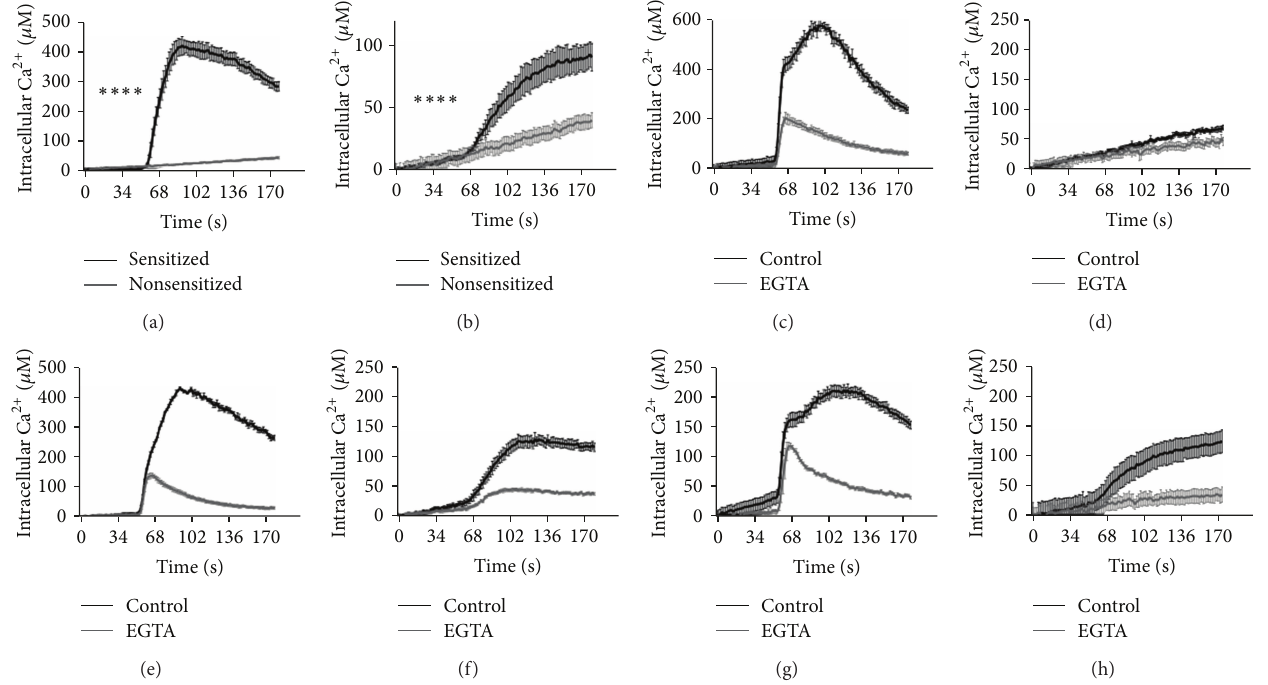
Figure 4: Calcium mobilisation in mast cell subsets. Fura-2/AM-loaded resting, nonsensitised (a) & (b) or anti-DNP IgE (0.5 𝜇 g/mL)- sensitised (a)–(h) mucosal-type BMMC (e) & (f), CTMC (g) & (h) and PDMC (a)–(d) were stimulated at 50s with DNP (0.5 𝜇 g/mL) to induce cross-linking (XL) of Fc 𝜀 R1 (a), (c), (e) & (g) or 0.5 𝜇 g/mL LPS (b), (d), (f) & (h), and intracellular calcium mobilisation and influx recorded in real time using excitation-emission ratios of 340/380 nm (a)–(h). For analysis of intracellular mobilisation alone, the cells were stimulatedincalciumfreeHBSSsupplementedwith100 𝜇 MEGTAtoremoveallextracellularcalcium(EGTA).Calciumlevelswerecalculated from 𝑅 max and 𝑅 min values and the data are presented as the mean calcium values of triplicate samples (base line calcium values subtracted) from a single experiment representative of at least 3 independent